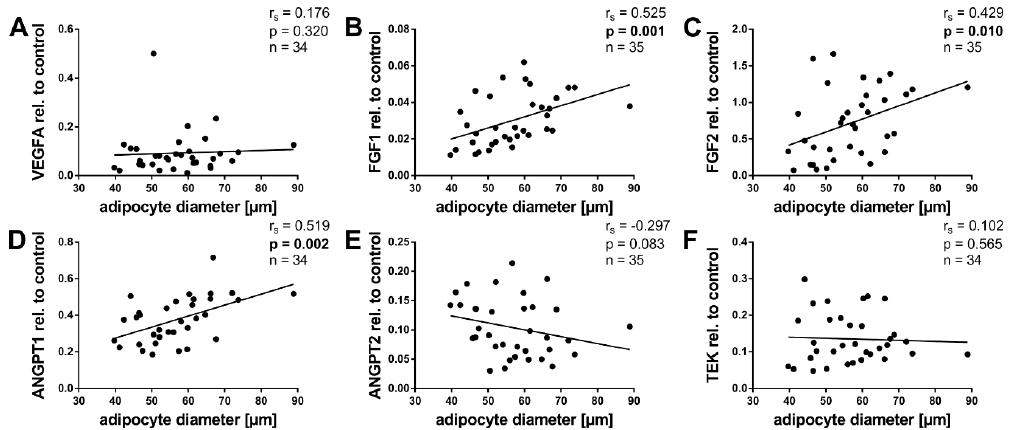
Figure 4. Association of angiogenic gene expression in pediatric WAT with adipocyte size. Total RNA was isolated, reverse transcribed, and subjected to qPCR analysis using specific primer pairs as indicated. Respective gene expression was calculated as described in Methods and plotted against adipocyte diameter. ( B – D ) FGF1, FGF2, and ANGPT1 showed a positive correlation with adipocyte diameter. ( A , E , F ) VEGFA, ANGPT2, and TEK, in contrast, showed no significant correlations with adipocyte diameter. Spearman correlation coe ffi cient r s and p value, as well as number of subjects, are given in each scatter plot. Significant p values ( p < 0.05) are indicated in bold. Trend lines were calculated as linear